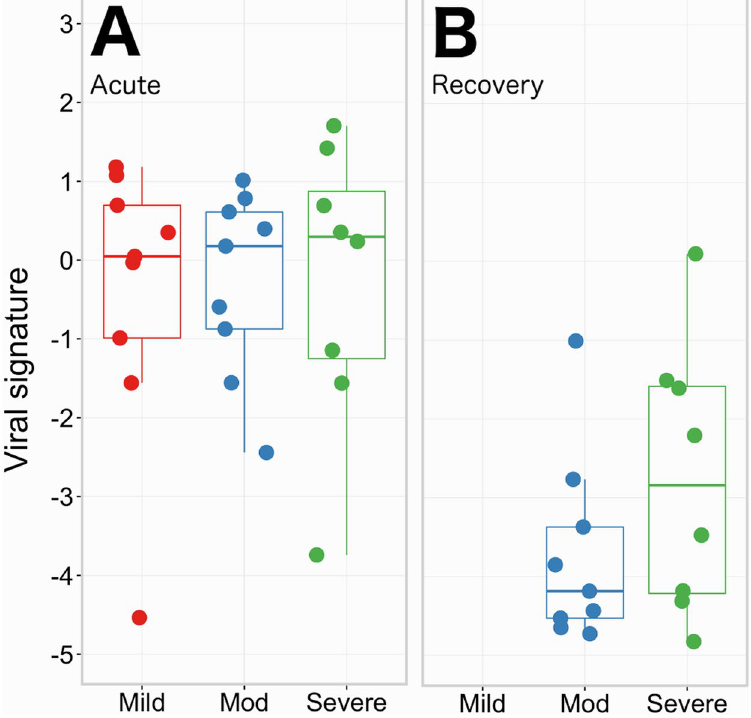
Figure 4. Pan-viral signature score for children with acute RSV infection and following recovery. Box and whisker plots for dataset GSE69606. Panel (A): pan-viral signature for children with acute RSV infection. Panel (B): pan-viral signature for moderately and severely affected children in recovery (4–6 weeks later). AUC = 0.903 for the difference between acute and recovery datasets. Abbreviation: Mod,